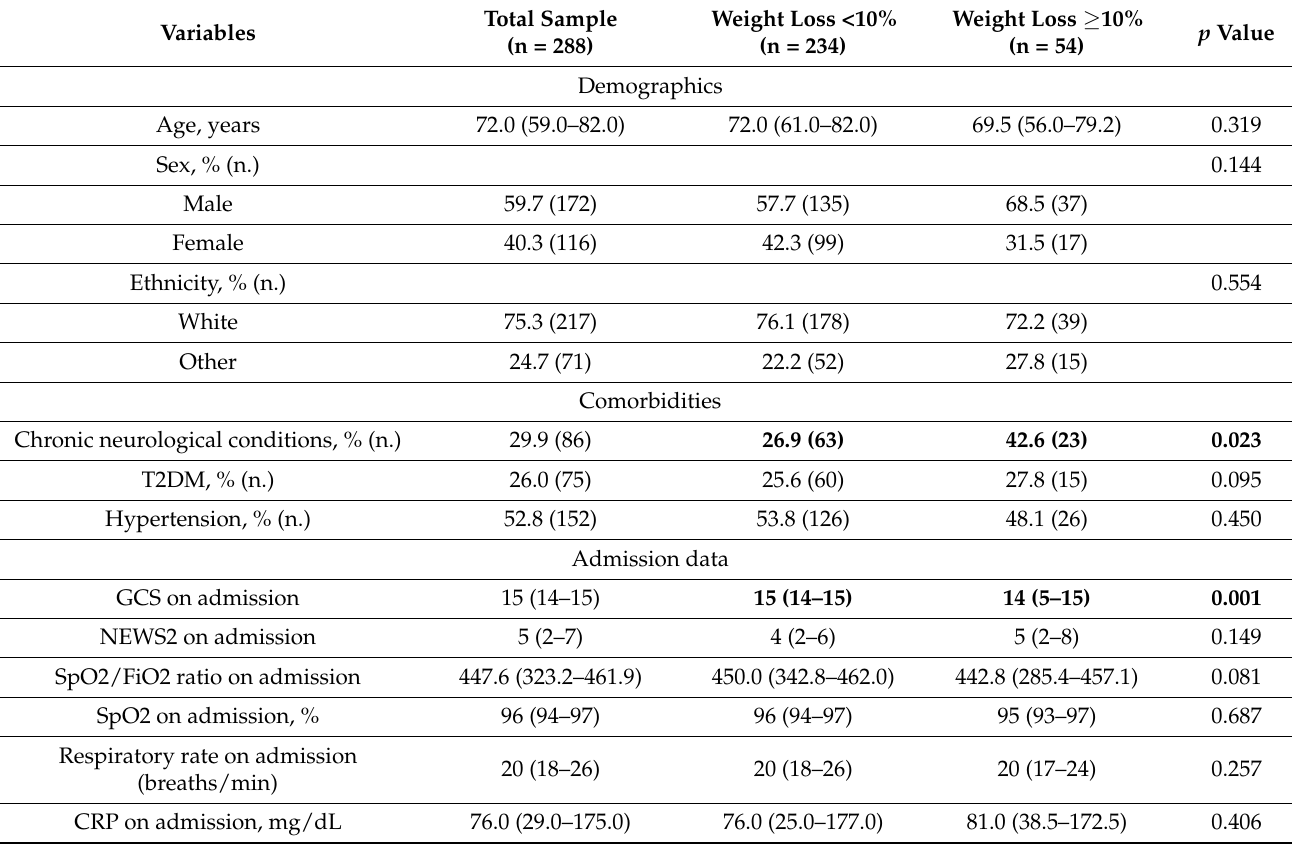
Table 1. Descriptive characteristics of the total sample (n = 288) and comparisons between